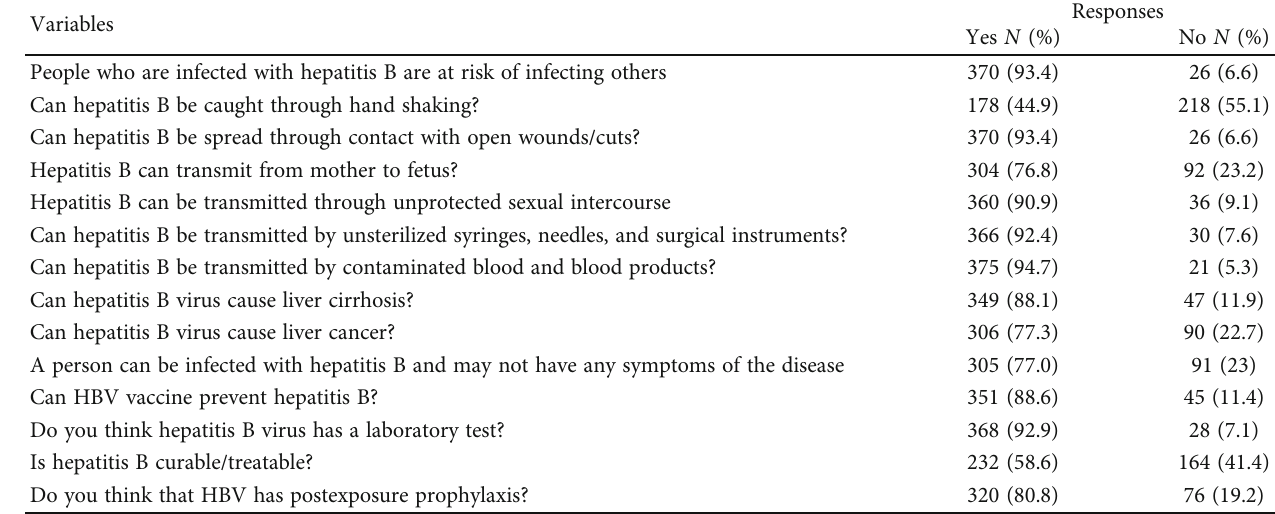
Figure 1: Knowledge level of students towards HBV prevention at HUCMHS, Hawassa, Ethiopia, 2021. Table 2: Frequency distribution of students ’ knowledge score towards hepatitis B virus infection prevention at HUCMHS, Hawassa, Ethiopia, 2021 ( n = 396